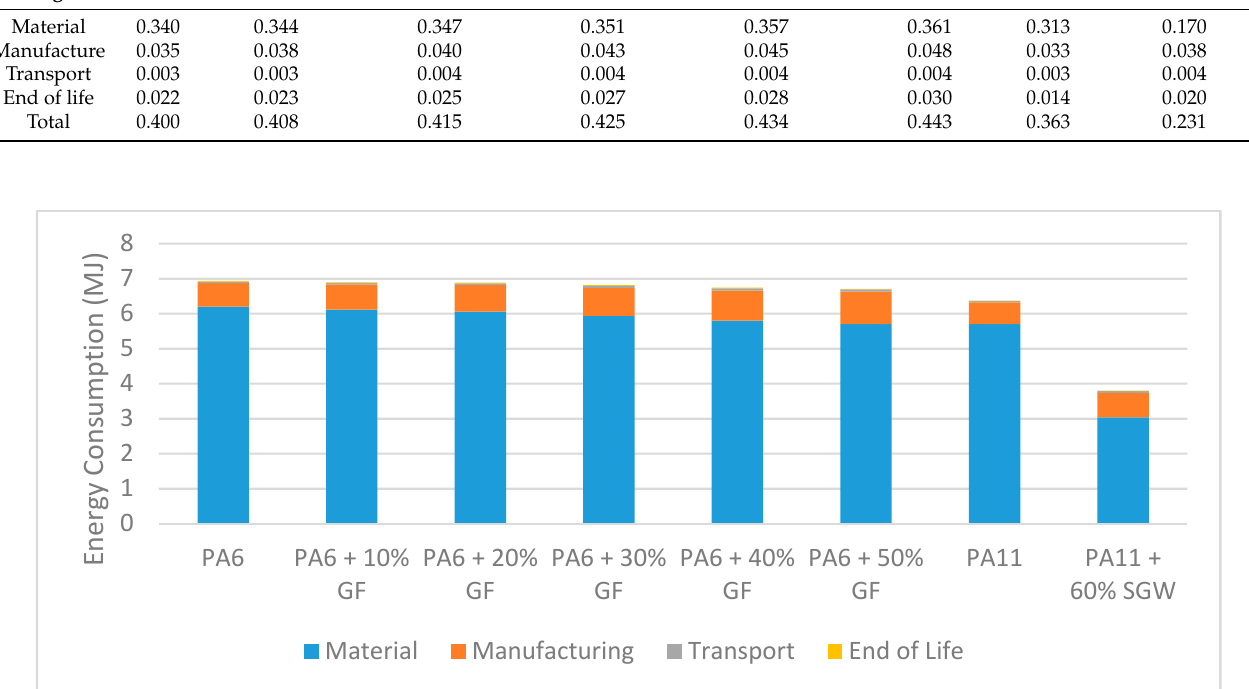
Figure 8. Energy consumption over a 10-year life cycle. Due to the fact that PA11 is not included in the database of the sustainability module Table 5. Energy consumption (MJ) by LCA stage for various materials with a life expectancy of 10 years. of SolidWorks, and the fact that this software does not allow the creation of new entries, the material was assumed to have the same properties as PA6, and the pedal volume was altered to have the same density as PA11. This was another conservative assumption since PA11 production does not increase atmospheric CO 2 emissions because the equivalent amount of CO 2 is absorbed during new plant growth; in addition, the consumption energy for PA11 production is lower than that for any other polyamide [63]. As a result, the LCA significantly overestimated the carbon footprint for the proposed pedal with a bio-based polymer matrix. Even so, as shown in Figure 7, producing a pedal body of bio-based com- posite is clearly more environmentally sustainable than producing synthetic